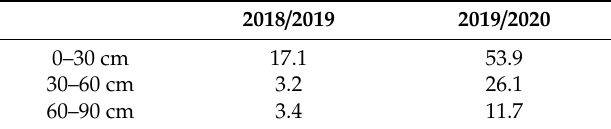
Table 2. Mineral nitrogen [kg / ha] at the time of sowing in 2018 / 2019 and 2019 / 2020.